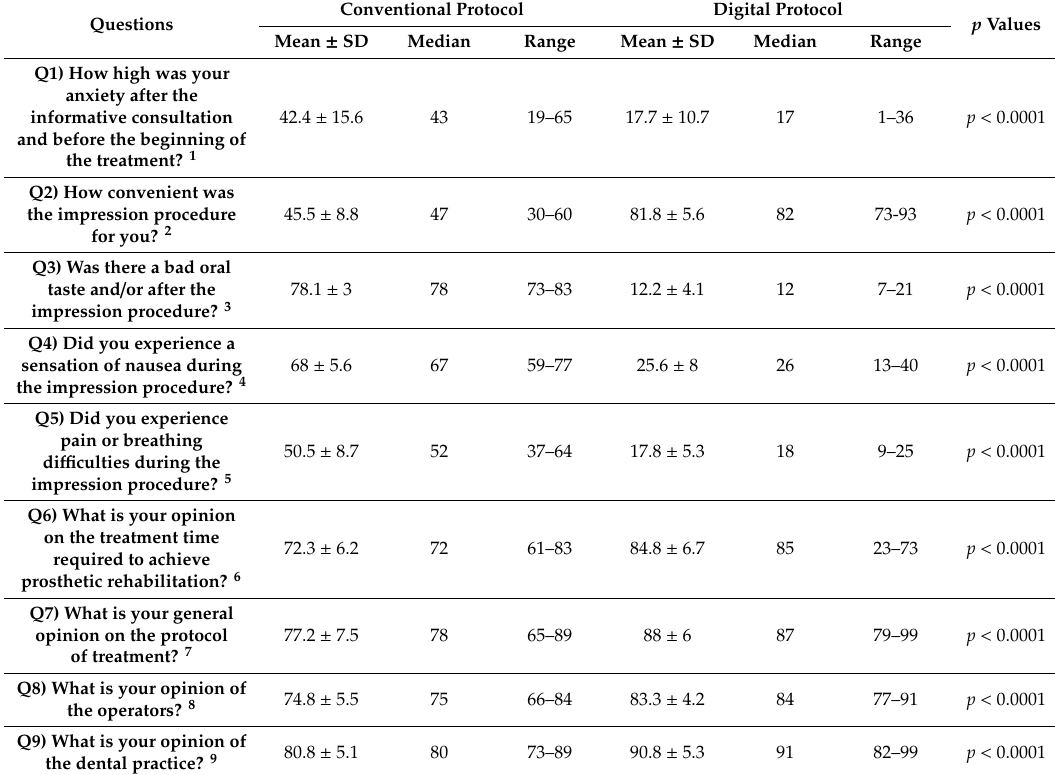
Table 1. Questions on patient satisfaction with digital and conventional protocol and mean scores of the